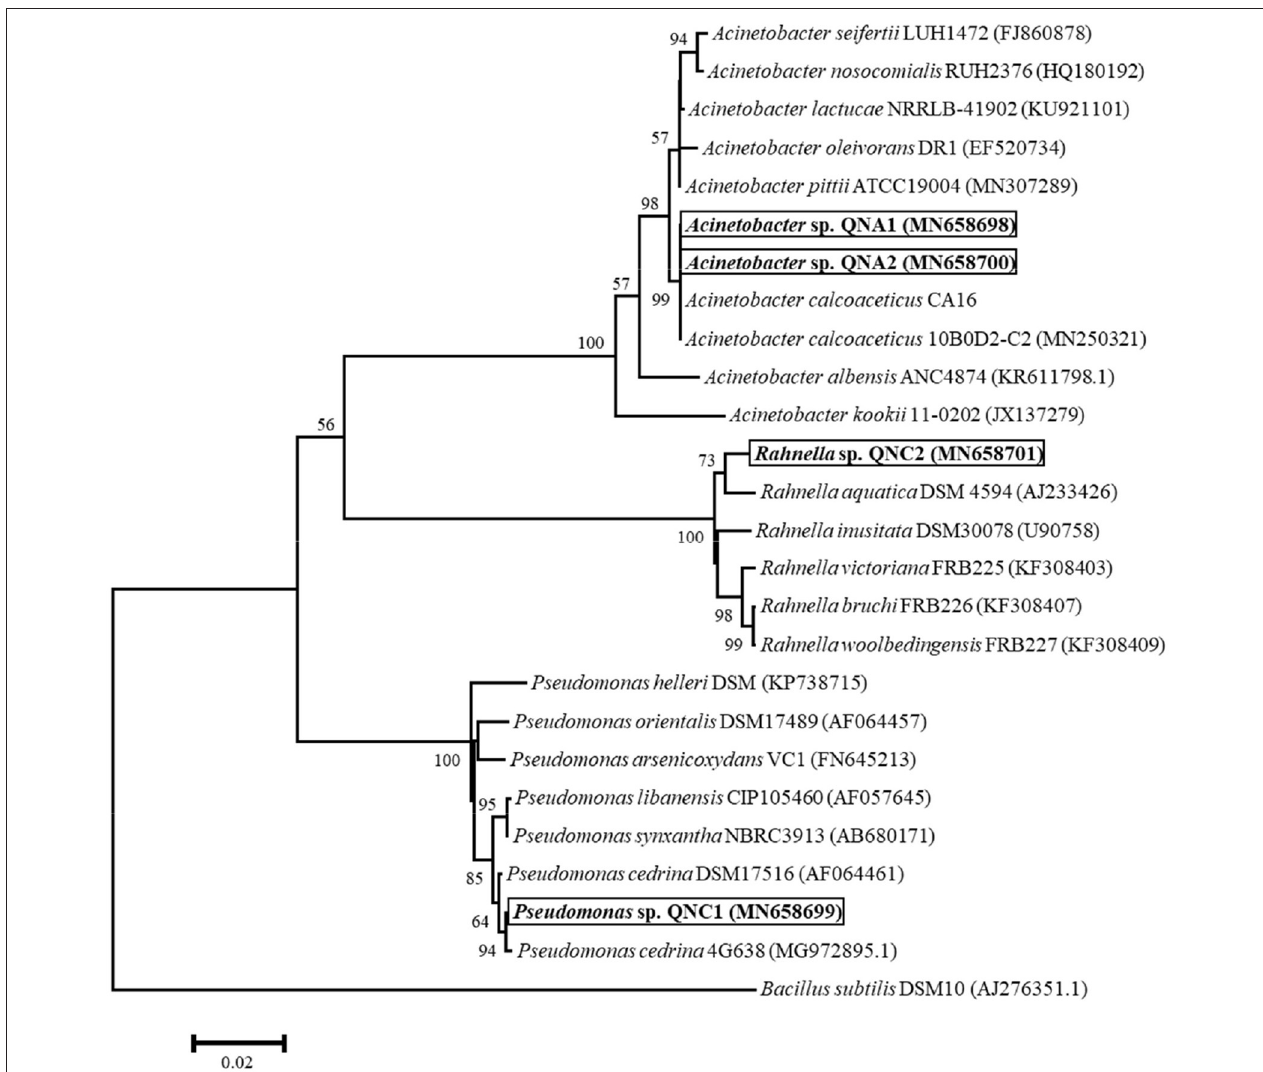
FIGURE 1 | The phylogenetic tree of partial 16s rRNA gene sequences, showing the position of Pseudomonas sp. QNC1, Rahnella sp. QNC2, and Acinetobacter sp. QNA1 and QNA2 strains in addition to taxonomically closest reference strains. The analysis was conducted by the neighbor-joining method with Kimura’s two-parameter calculation model in MEGA version 6.0. The scale bar represents the number of substitutions per site. Numbers at branching points indicate bootstrap value derived from 1,000